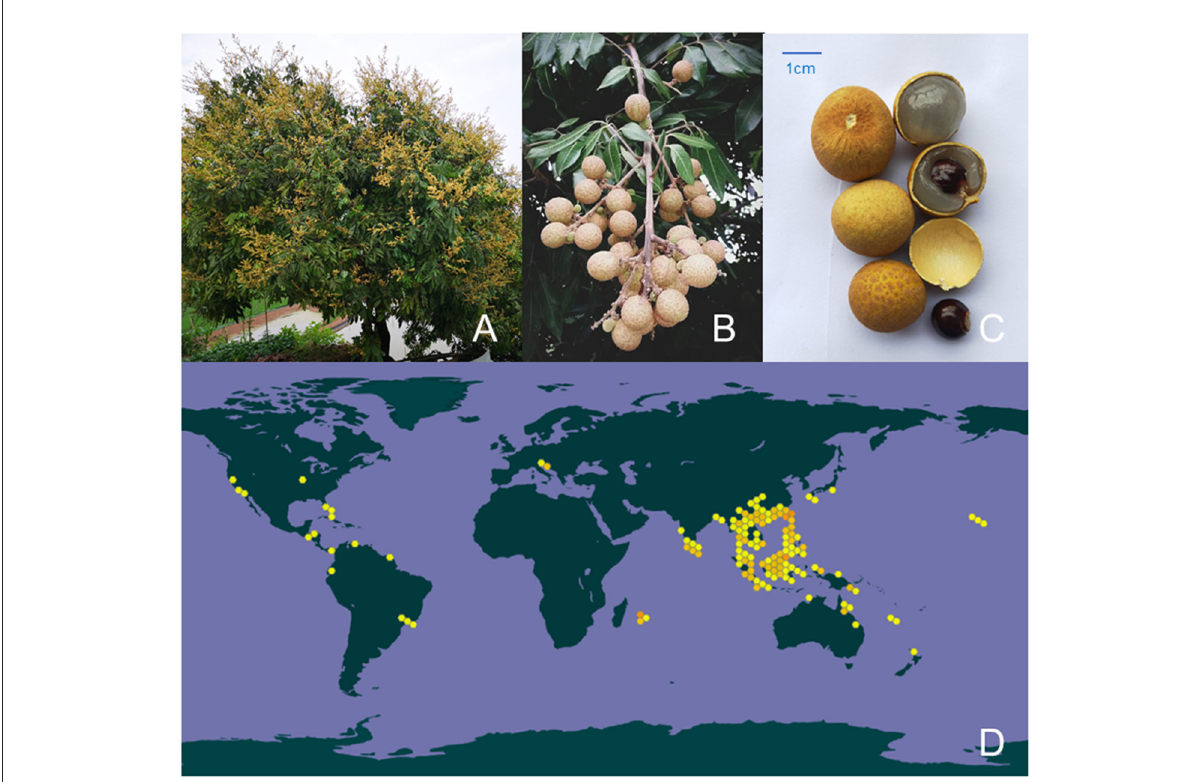
FIGURE1 Botanical characteristics and the distribution of longan in the world. (A) The plant of longan, (B) the fruit of longan, and (C) different parts of longan fruit. (D) The approximate distribution of longan in the world (Data from the Global Biodiversity Information Facility, color figure can be viewed at